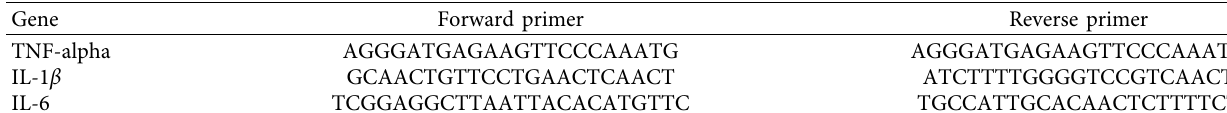
Table 1: Primer sequences.